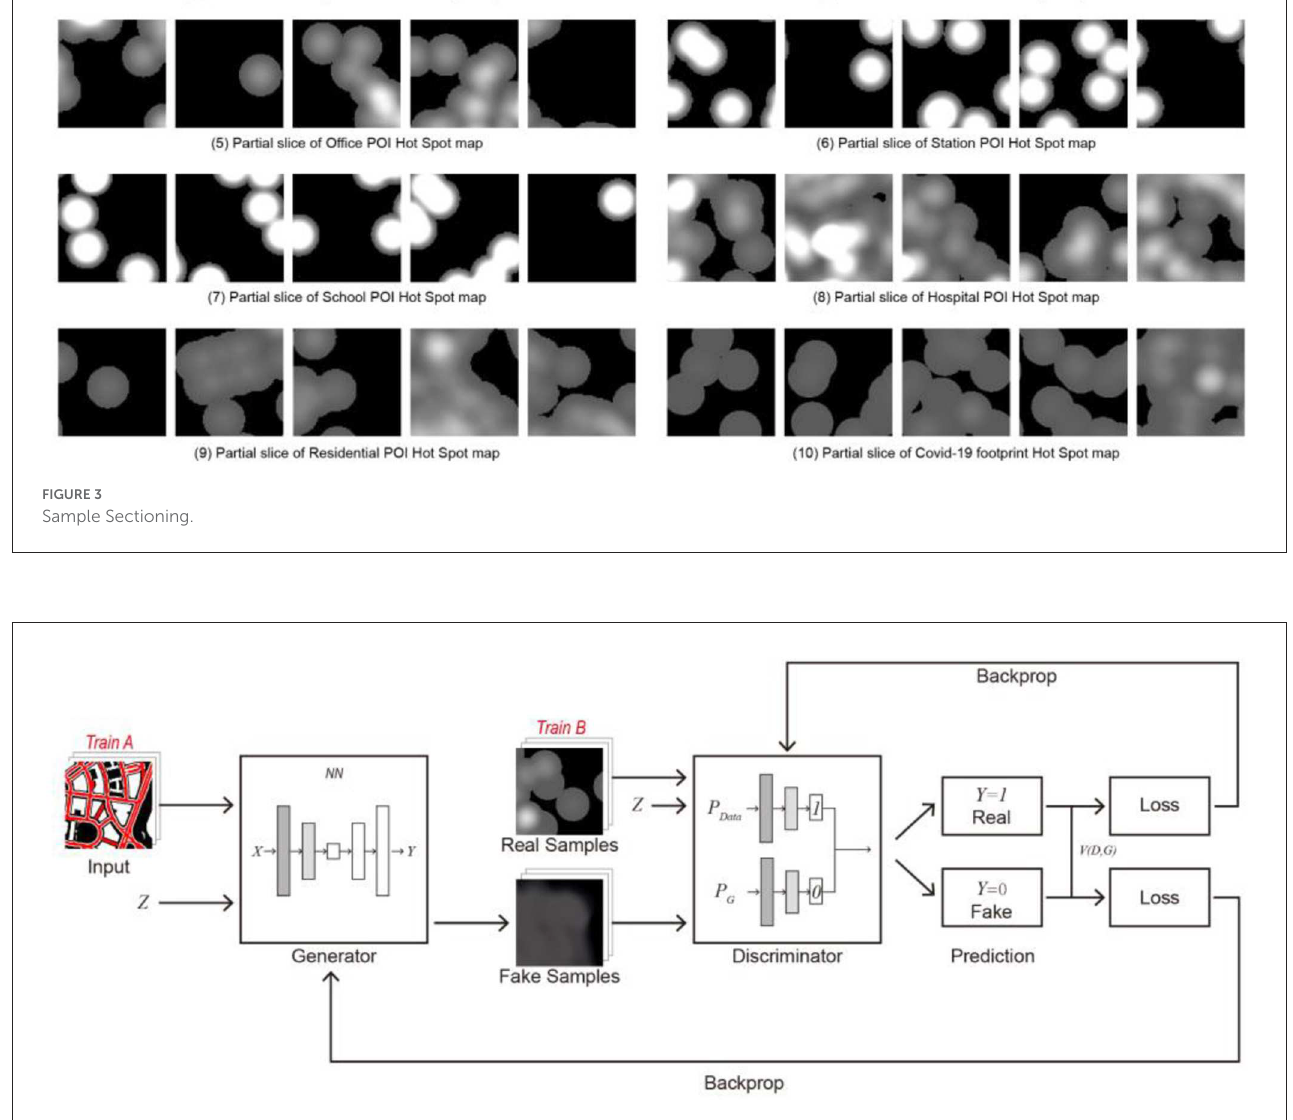
FIGURE4 Principle of CGAN.